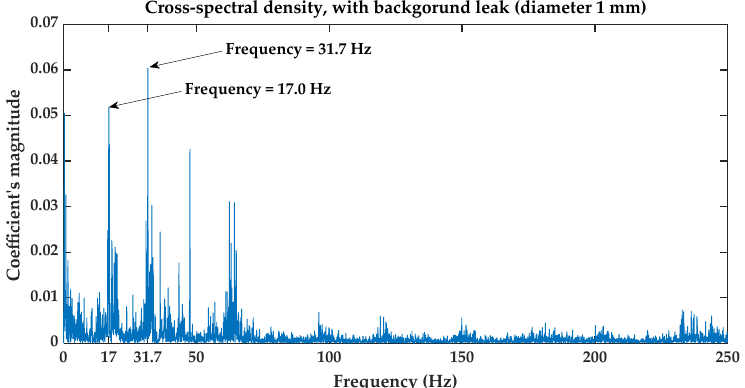
Figure 10. Cross-spectral density, with background leak (1 mm in diameter) and flow rate 33.7 mL/s .